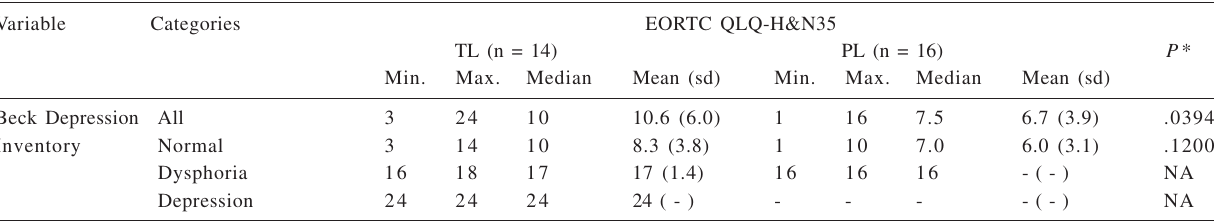
Table 5 - Results of the Beck Depression Inventory by surgery group.